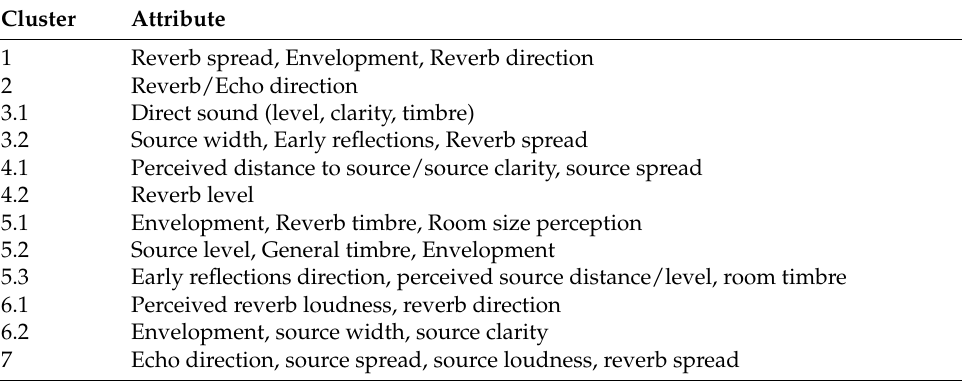
Table 3. Lab experiment main construct categories based on